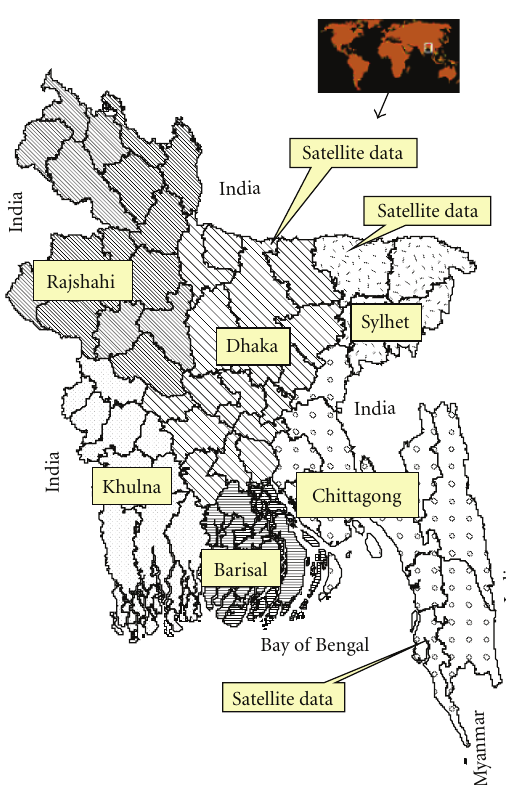
Figure 1: Geographical map of Bangladesh.